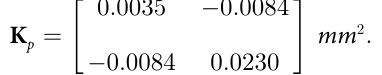
ffiffi p ð 5 : 45 Þ ¼ 8 : 57 , for 20 mm water thickness on the right filtered detector side ffiffiffiffiffiffiffiffiffi p 20 = 2 : 47 ¼ 12 : 73 , for 1 mm of bone on the unfiltered detector side 1 = 1 mm of bone on the filtered detector side 1 = were: for the 6 mm of Titanium on the unfiltered detector side 6 = the 5 mm of Titanium on the filtered detector side 5 =